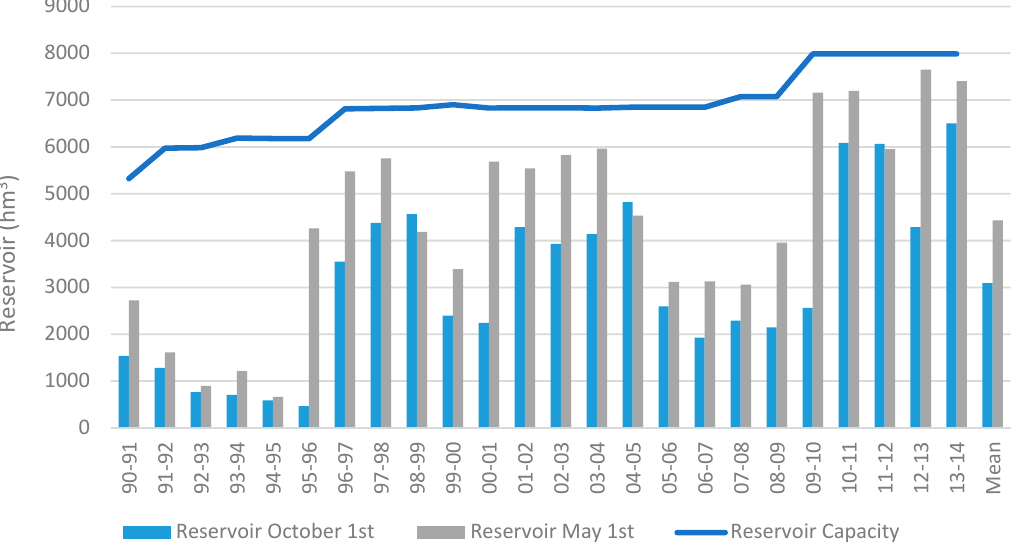
Figure 3. Water storage in the Guadalquivir River Basin (1990–2014) (Source: Guadalquivir River Basin Authority).